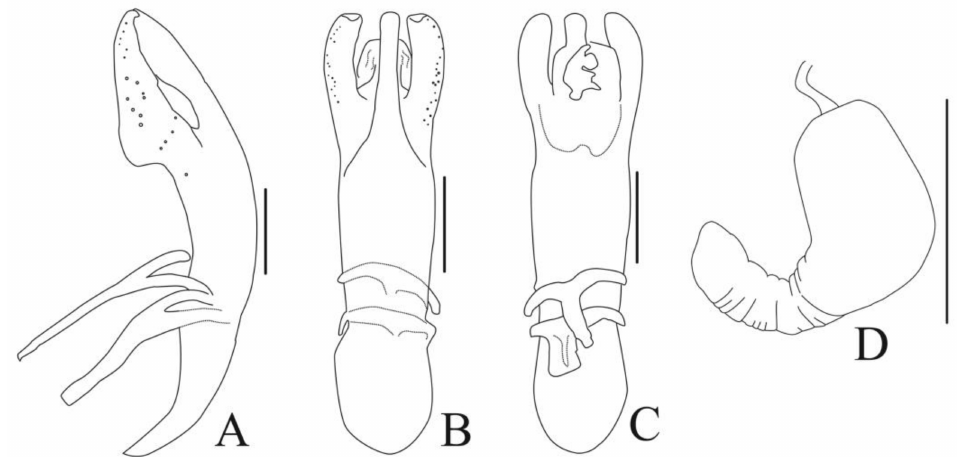
Figure 5. Cryptocephalus ( Burlinius ) baowenzhengi Duan & Zhou, sp. nov.: ( A ) lateral view of aedeagus; ( B ) dorsal view of aedeagus; ( C ) ventral view of aedeagus; ( D ) spermatheca (Scale bars: 0.2 mm). Description. Body (Figure 4A) is elongated cylindrical, smooth, shining, and steel-blue colored. The head is mostly yellow, with a vertex that is pitchy brown, antennae with basal five segments that are yellowish-brown, and remaining segments that are darkish